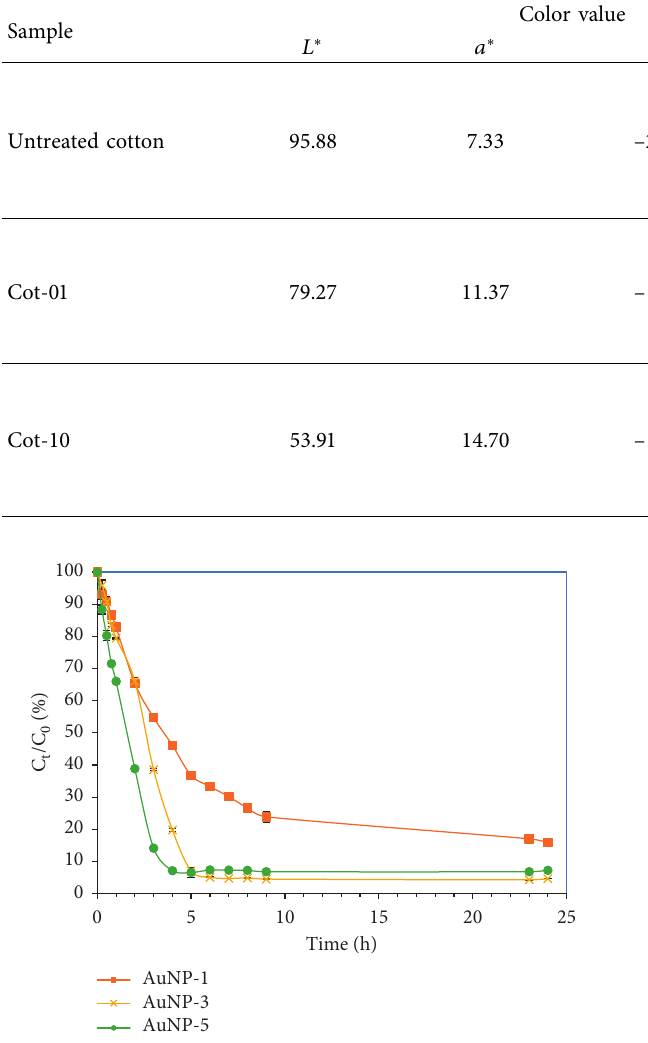
Figure 5: Catalytic reduction of CR using AuNPs ( C dye concentration, and C is the dye concentration at time t ).